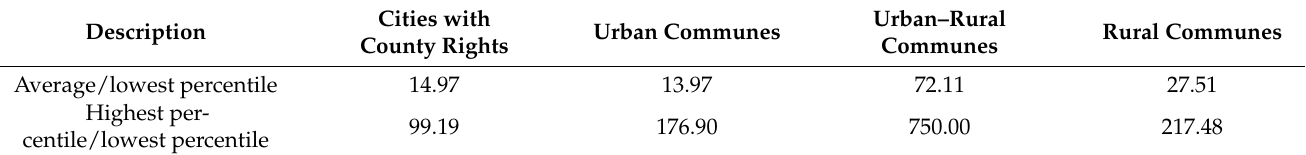
Table 7. Differentiation of the surface of degraded areas in the respective types of the communes.